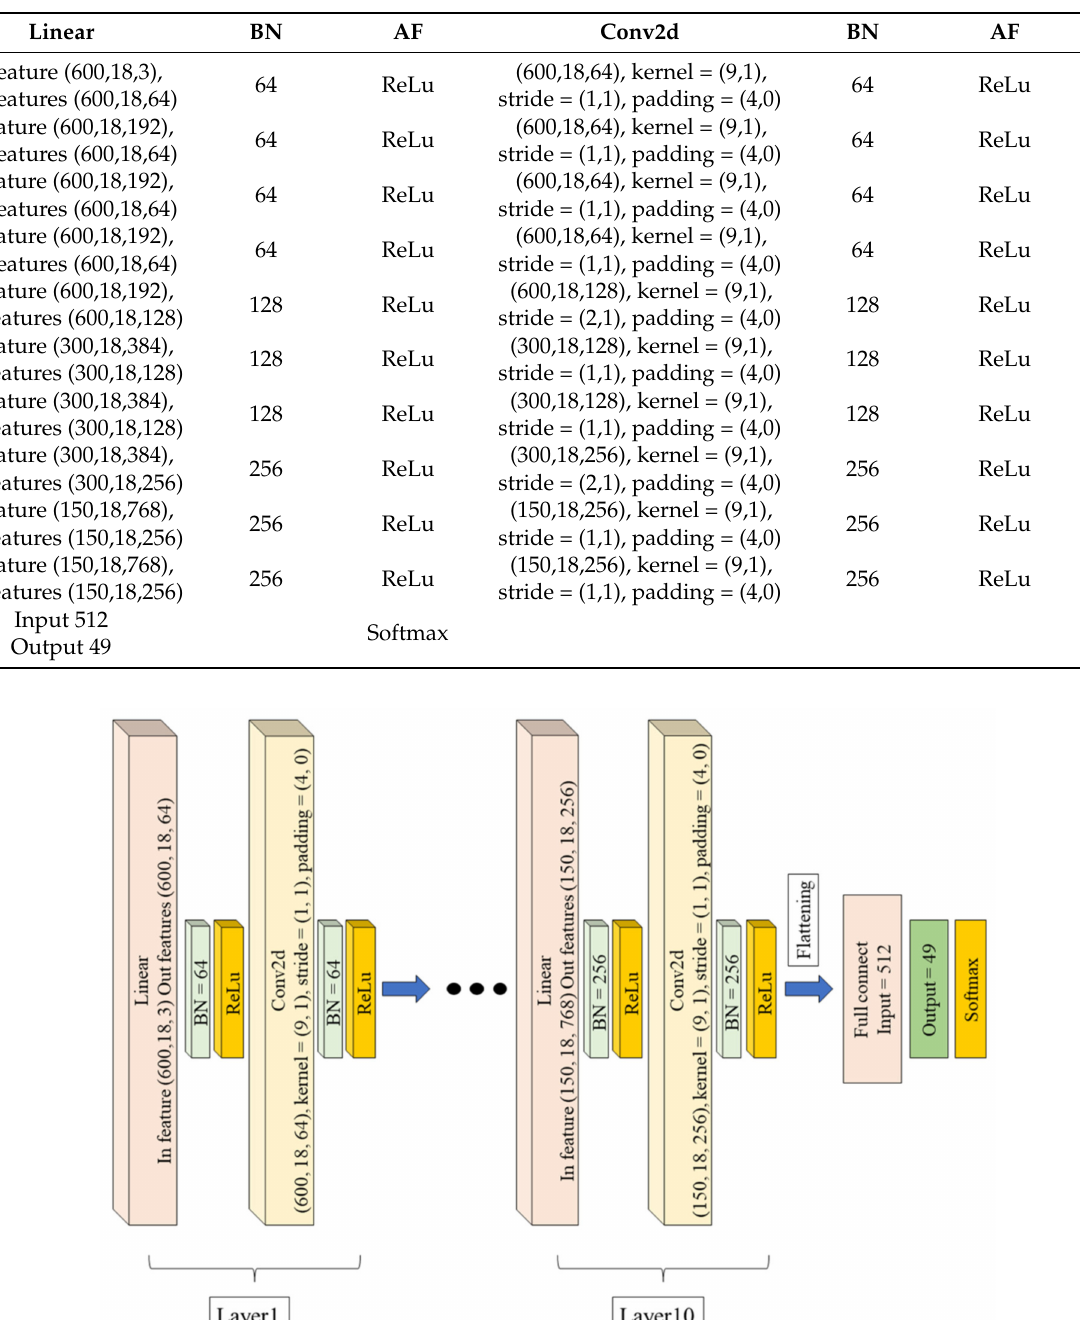
Table 4. The parameters of linear-map CNN in each layer.